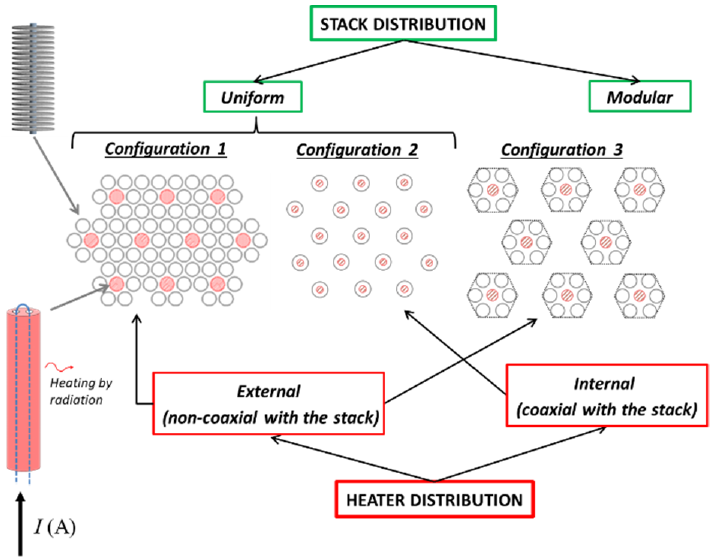
Figure 2. The three different configurations investigated for an NEG pump of relevant scale.